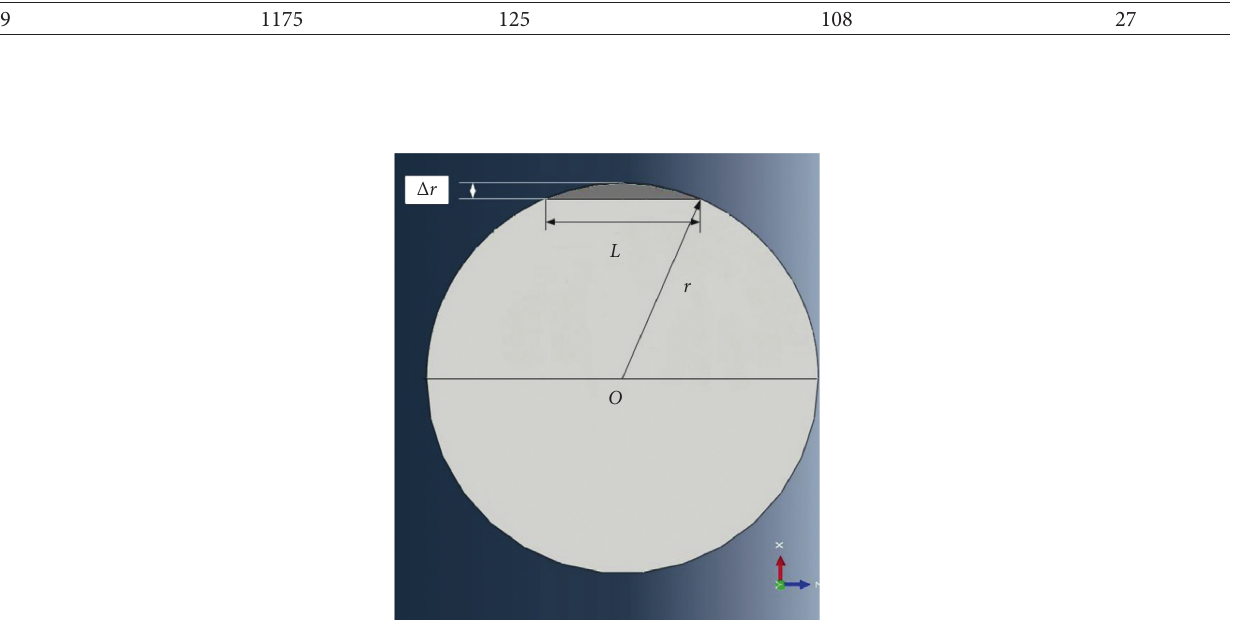
Figure 17: Breathing crack model of pillar porcelain insulator.